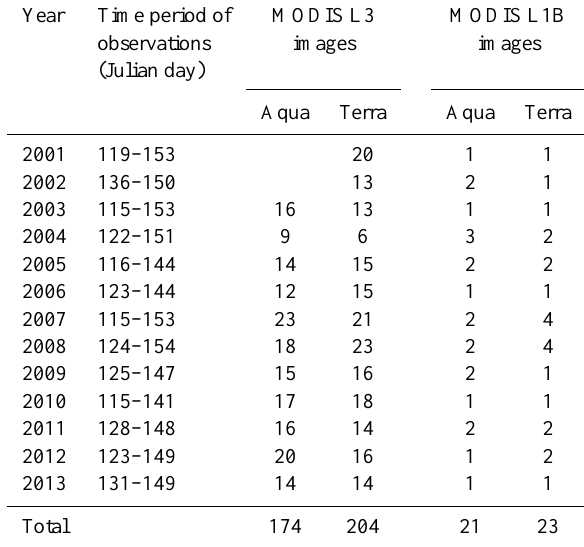
Table 3. Time periods of observations and number of MODIS L3 and L1B images analysed during break-up on the Mackenzie